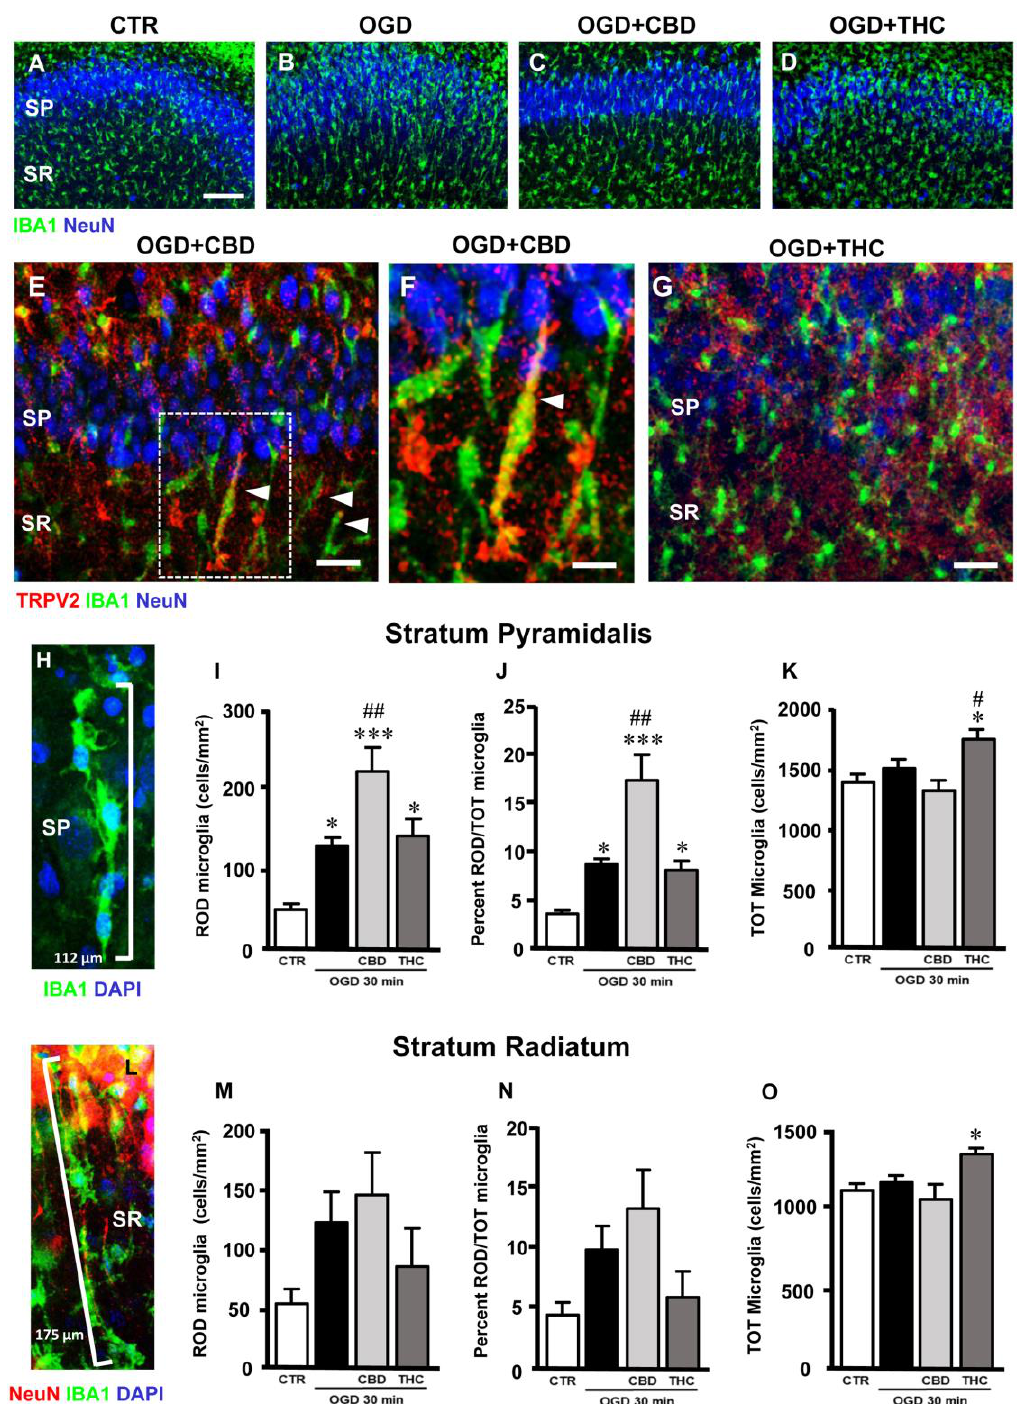
Figure 4. ( A – D ) Representative confocal images of immunostaining of neurons (NeuN, blue) and total microglia (IBA1, green) in CA1 SP and SR of CTR ( A ), OGD ( B ), OGD + CBD ( C ), and OGD + THC ( D ) slices. Images are z-projections of a single confocal z-scan captured with a 20× objective (total thickness: 1.2 µm). Scale bar: 75 µm. In OGD slices, many microglia acquired a rod-like morphology, with elongated cell bodies ranging from 40 µm to over 100 µm, and with their longer axis perpendicular to CA1 SP, while other microglia acquired a round morphology typical of activated microglia. ( E – G ) Representative confocal images of immunostaining of TRPV2 channels (TRPV2, red), total microglia (IBA1, green), and neurons (NeuN, blue) in CA1 SP and SR of an OGD + CBD ( E , F ) and an OGD + THC slice ( G ). Images are z-projections of three confocal z-scans captured with a 40× objective (total thickness: 1.8 µm). Scale bar for panels E,G: 20 µm. Scale bar for panel F: 10